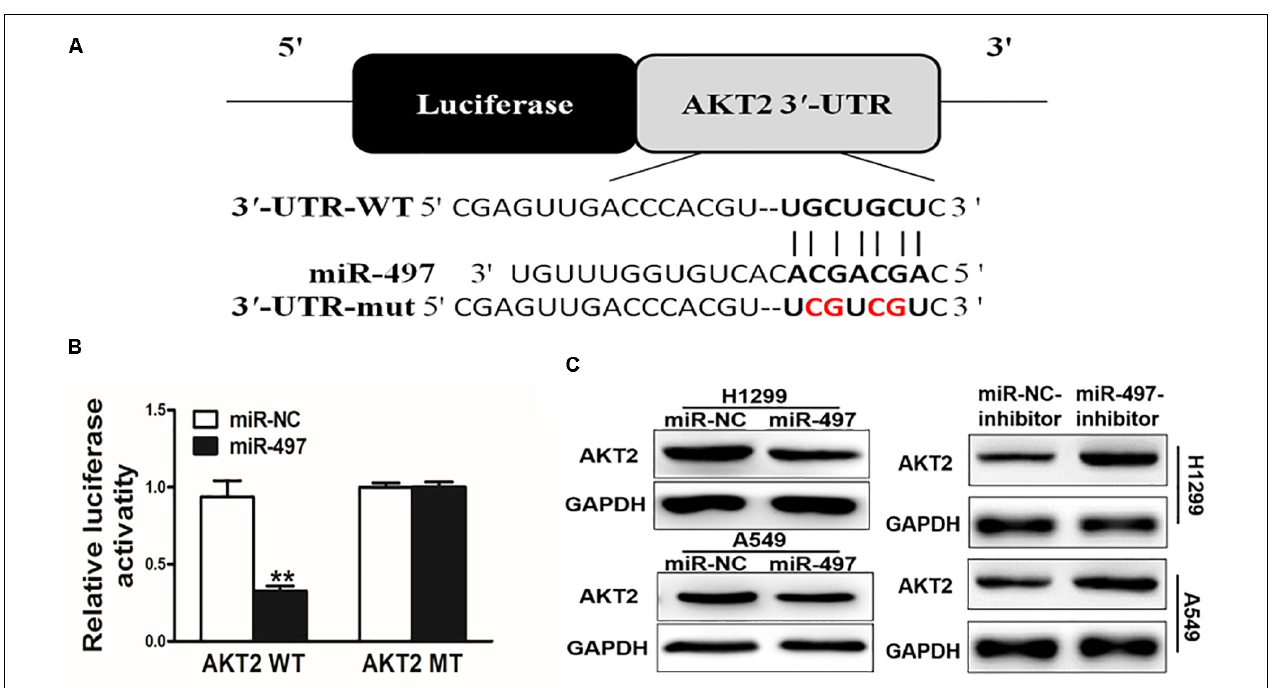
FIGURE 2 | AKT2 is a direct target of miR-497. (A) Putative seed-matching sites or mutant sites (red) between miR-497 and 3’-UTR of AKT2. (B) Reporter assay of miR-497 targeting AKT2. Luciferase activities of reporter constructs containing wild-type (WT) or mutant (MT) 3’-UTR of AKT2 were assayed and normalized to those of renilla activities (internal control). (C) Suppression of AKT2 protein levels by miR-497. Total proteins were subjected to western blotting and detected for AKT2 expression levels.